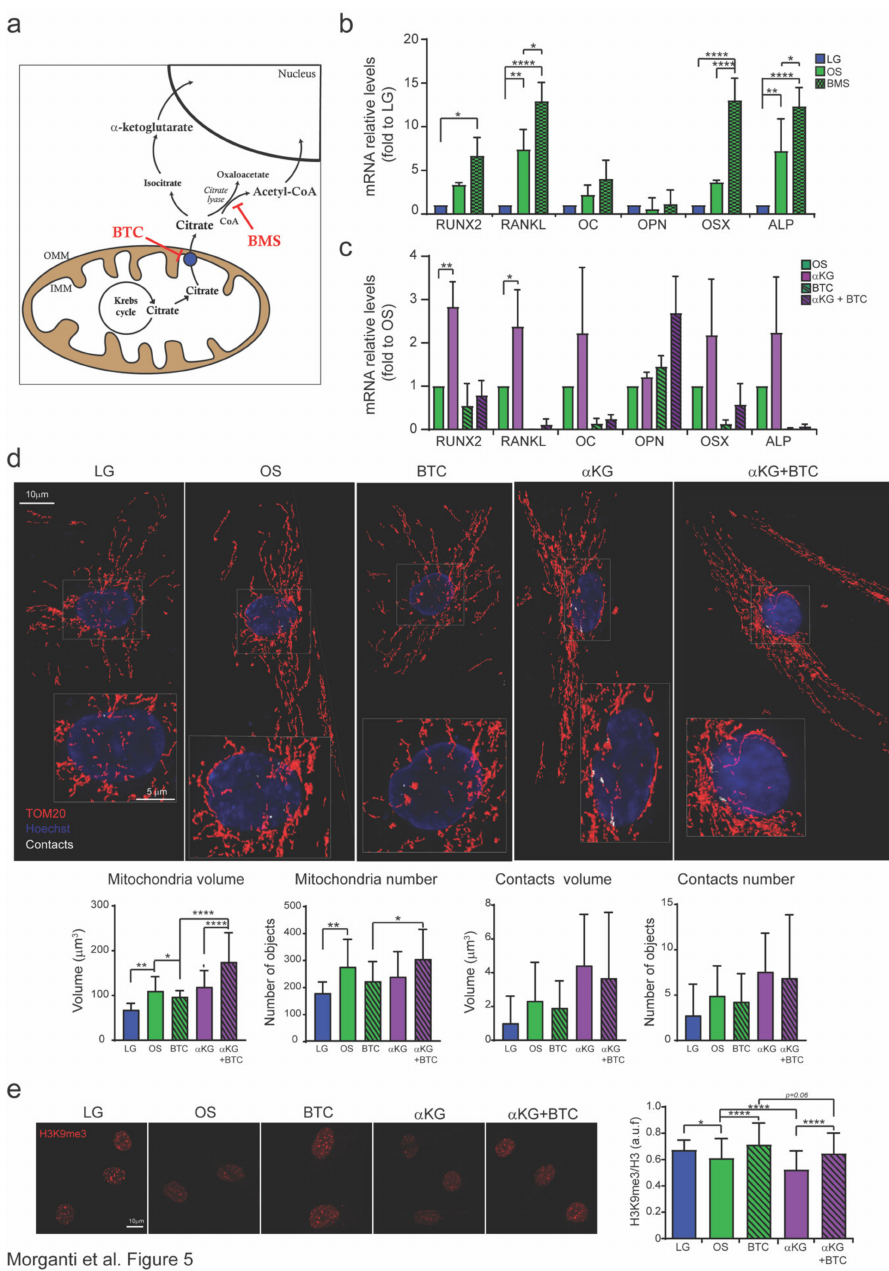
Figure 5. Citrate from mitochondria increases the level of α -ketoglutarate to promote osteogenesis. ( a ) Citrate can be converted to acetyl-CoA by citrate lyase (inhibited by BMS) or to α -ketoglutarate ( α KG), two metabolites that can mediate mitochondrion-nucleus communication. ( b , c ) Analysis of relative mRNA levels of osteogenic markers (RUNX2, RANKL, osteocalcin (OC), osteopontin (OPN), osterix (OSX), and alkaline phosphatase (ALP)) in MSCs cultured in low-glucose (LG) and osteogenic media (OS); where indicated, BMS [1 mM], BTC [5 mM], and α KG [1 mM] were added for 21 days. ( d ) Representative images and analysis of mitochondrial total volume and number detected by the anti-TOM20 Ab and the total volume and number of mitochondrion-nucleus contact sites in MSCs cultured in LG and osteogenic media (OS); where indicated, BTC [5 mM] and α KG [1 mM] were added for 21 days. ( e ) Representative images and quantification of H3K9me3 in MSCs cultured in LG and OS media; where indicated, BTC [5 mM] and α KG [1 mM] were added for 21 days. Magnification 40x. Scale bar 10 µ m (in zoom 5 µ m). Data are derived from ≥ 45 acquired cells / condition from ≥ 3 independent experiments and are shown as the mean ± SD. ANOVA-test. * p < 0.5, ** p < 0.01, *** p <